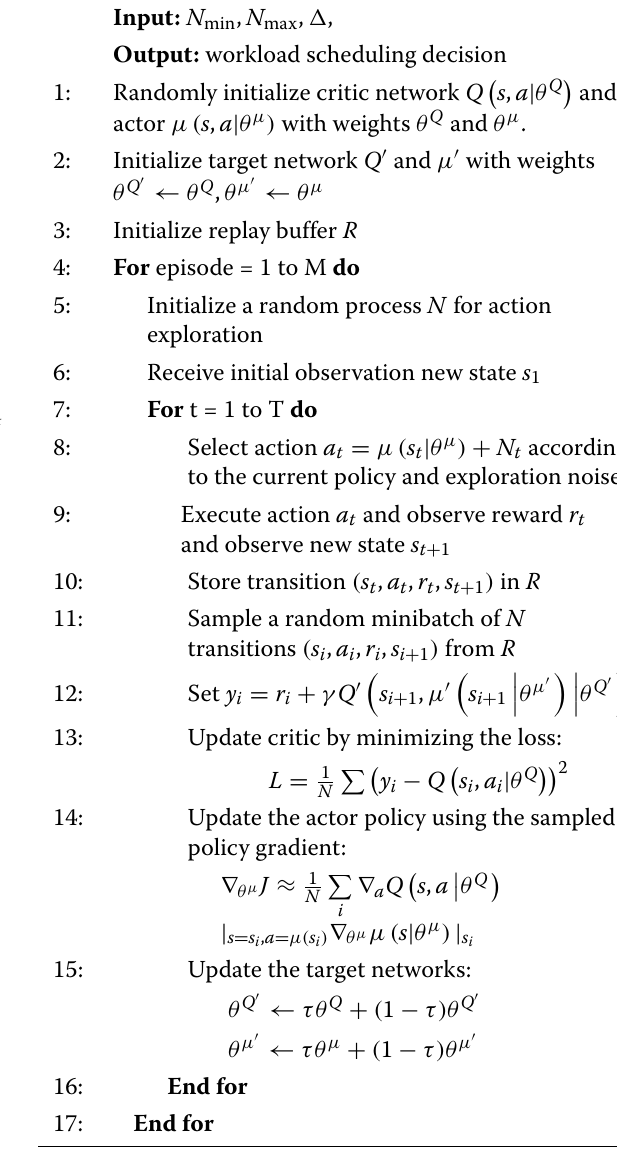
Algorithm 1 DQN-based Workload Scheduling Algorithm Algorithm 2 DDPG-basedWorkloadScheduling